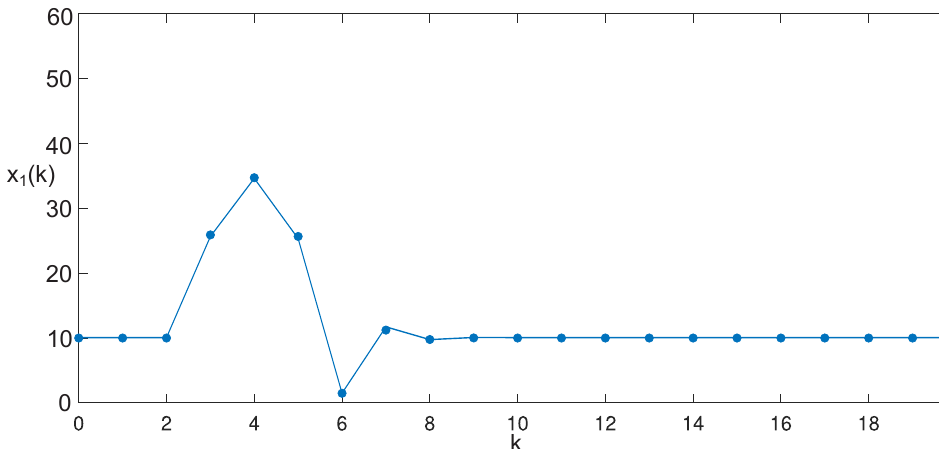
Figure 2. The manufacturer’s actual Fig. 5. State-feedback closed-loop response to the impulsive distur- bance w ( k ) in Fig. 2 (top-left panel).